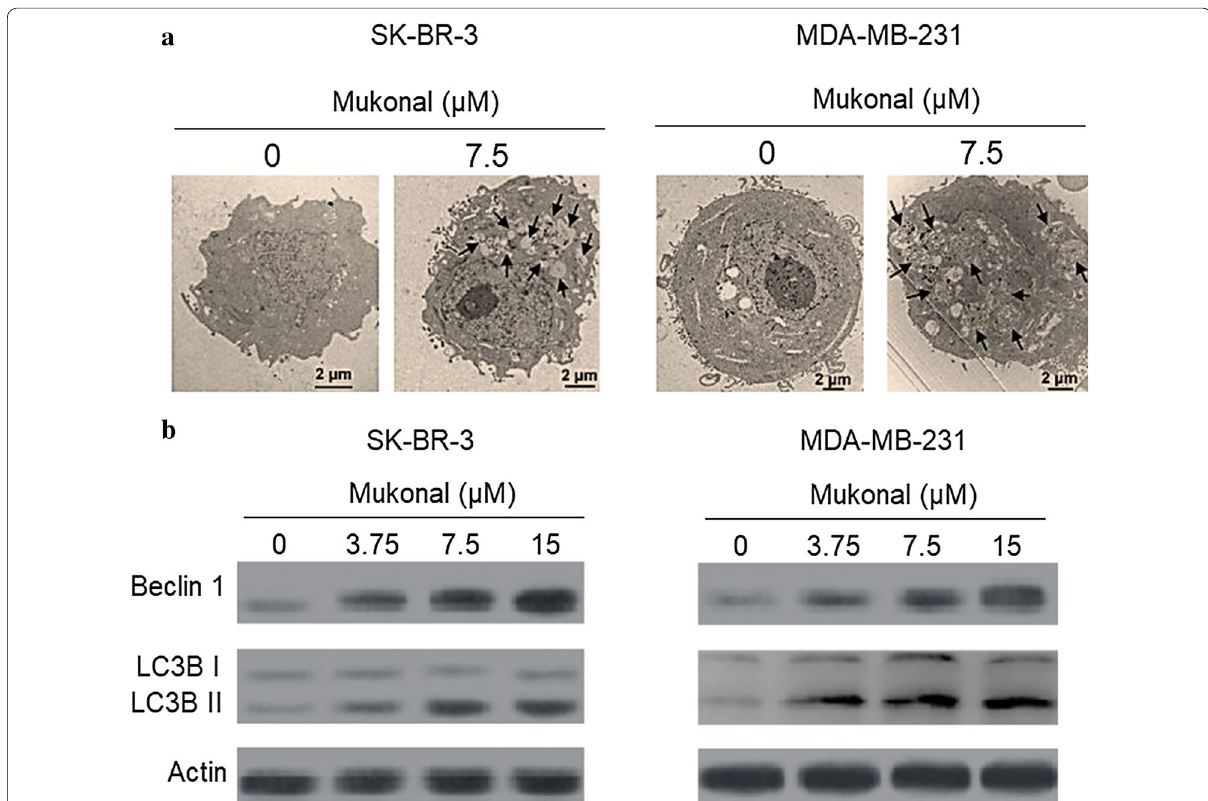
Fig. 4 a TEM analysis of SK-BR-3 cells after being exposed to indicated doses of mukonal. Results revealed formation of autophagic vesicles/ autophagosomes in treated groups as compared to control group. Autophagosomes have been shown by arrows in the picture. b TEM analysis of MDA-MB-231 cells after being exposed to indicated doses of mukonal. Results revealed formation of autophagic vesicles/autophagosomes in treated groups as compared to control group. Autophagosomes have been shown by arrows in the picture. c Western blotting results of SK-BR-3 cells after being exposed to mukonal at indicated doses. In treated groups enhanced activity of Beclin-1, LC3B-I and LC3B-II was observed with increasing concentrations of mukonal. d Western blotting results of MDA-MB-231 cells after being exposed to mukonal at indicated doses. In treated groups enhanced activity of Beclin-1, LC3B-I and LC3B-II was observed with increasing concentrations of